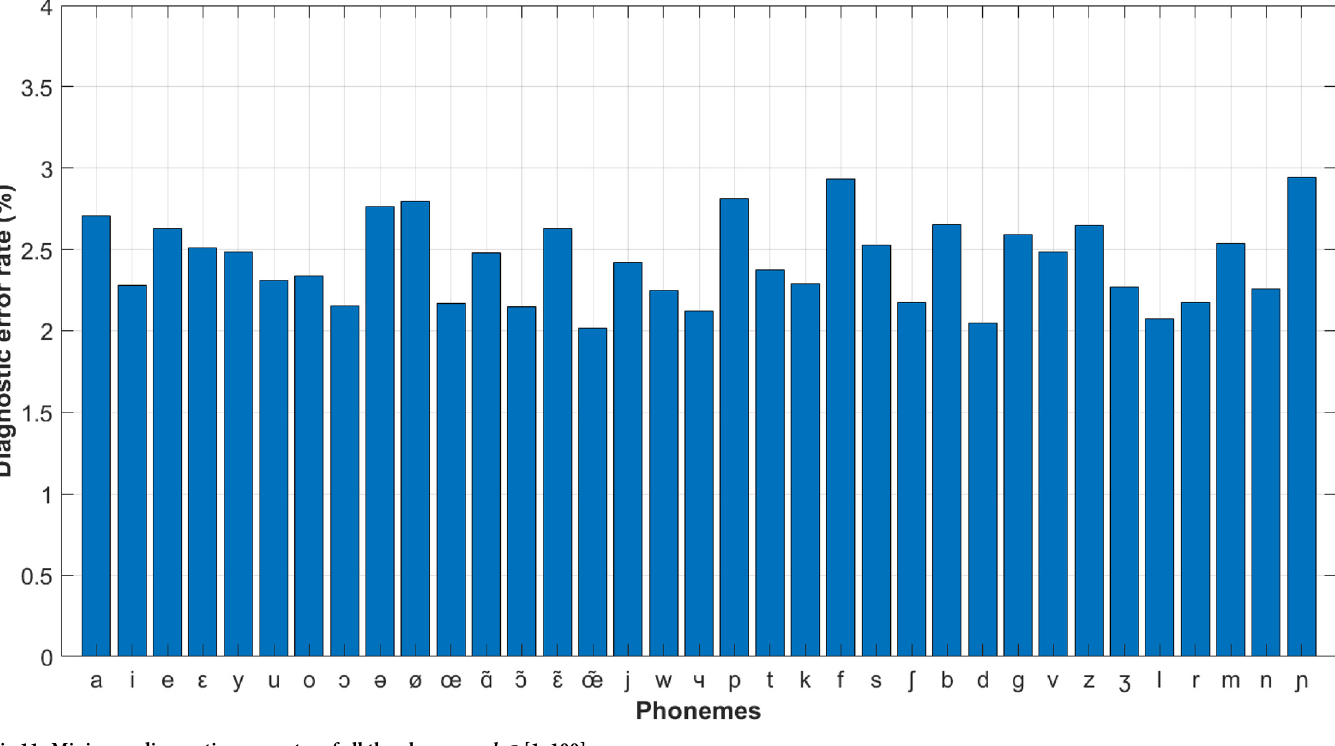
Fig 11. Minimum diagnostic error rates of all the phonemes: k 2 [1,